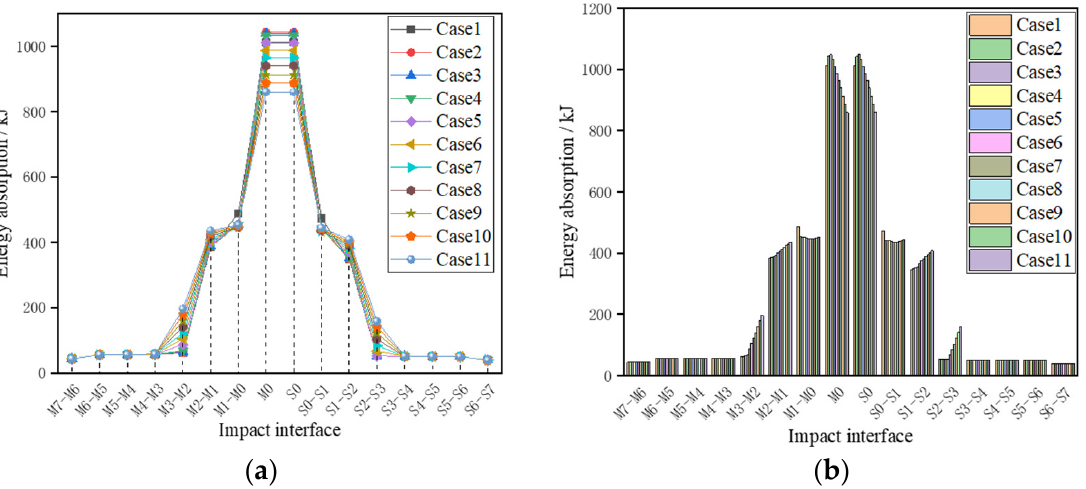
Figure 11. Energy distribution at each interface with the change in the initial peak force.